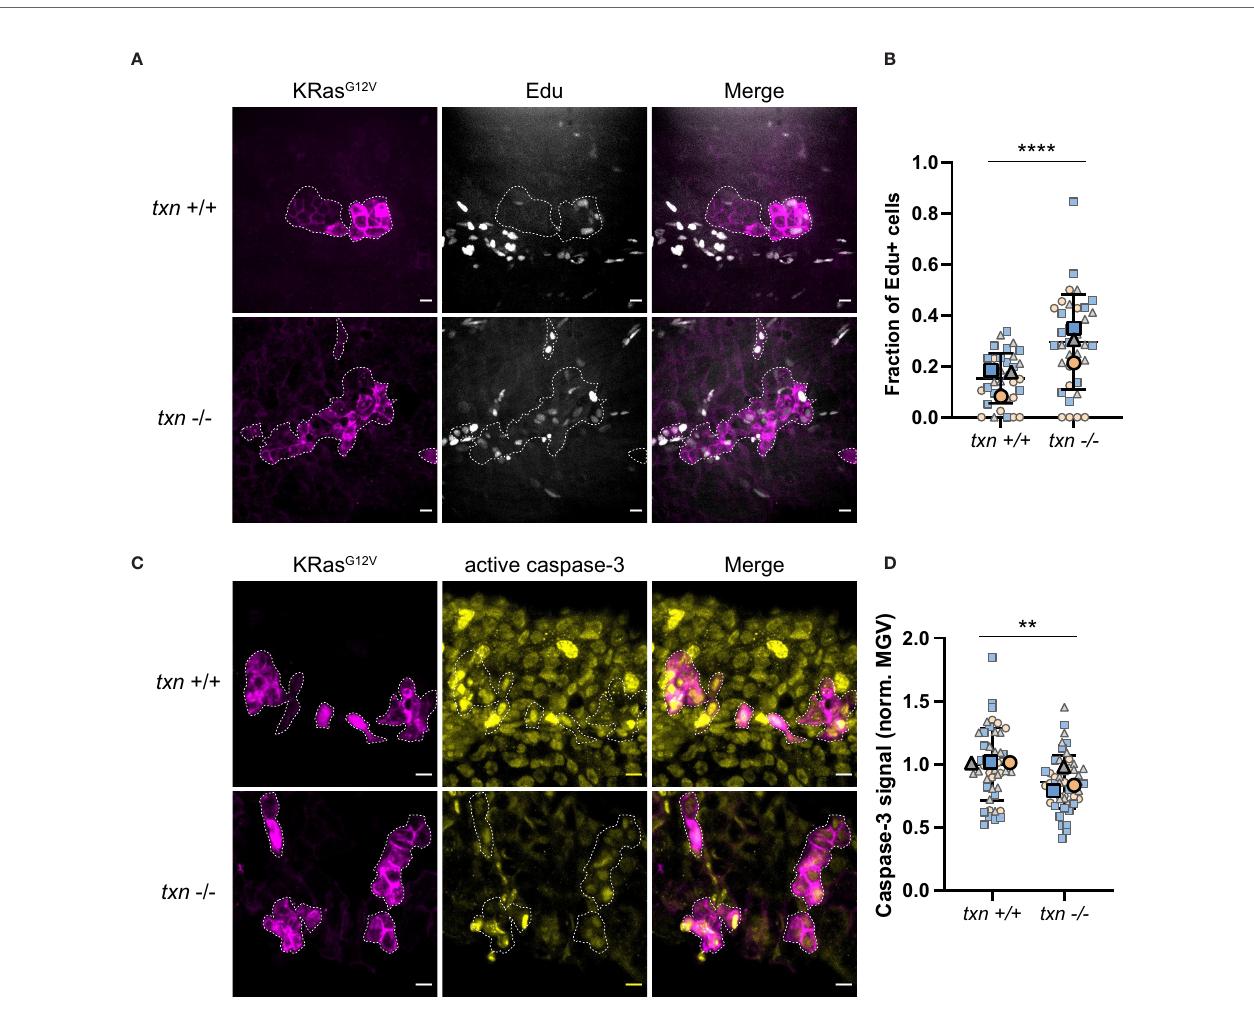
FIGURE 5 | Transformed keratinocytes exhibit increased proliferation and reduced apoptosis during tumor initiation in thioredoxin mutants. (A) EdU staining (white) of txn +/+ or txn -/- larvae with KRas G12V -expressing basal keratinocytes (magenta) at 3dpf. (B) Quanti fi cation of the frequency of EdU-positive KRas G12V -expressing basal cells 3dpf in txn wt (n=35) and mutant (n=35) larvae. (C) Cleaved caspase-3 immuno fl uorescence of txn +/+ or txn -/- larvae. (D) Quanti fi cation of relative signal intensity within transformed cells 3dpf in txn +/+ (n=45) and txn -/- (n=51) larvae. Scale bar, 10um. Large, bolded shapes indicate average value per replicate (n), with small shapes representing data points from independent larvae. Samples were analyzed for statistical signi fi cance via t-test (p < 0.001***, p <